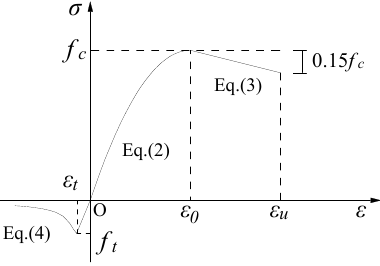
Figure 9. Constitutive relation of concrete.